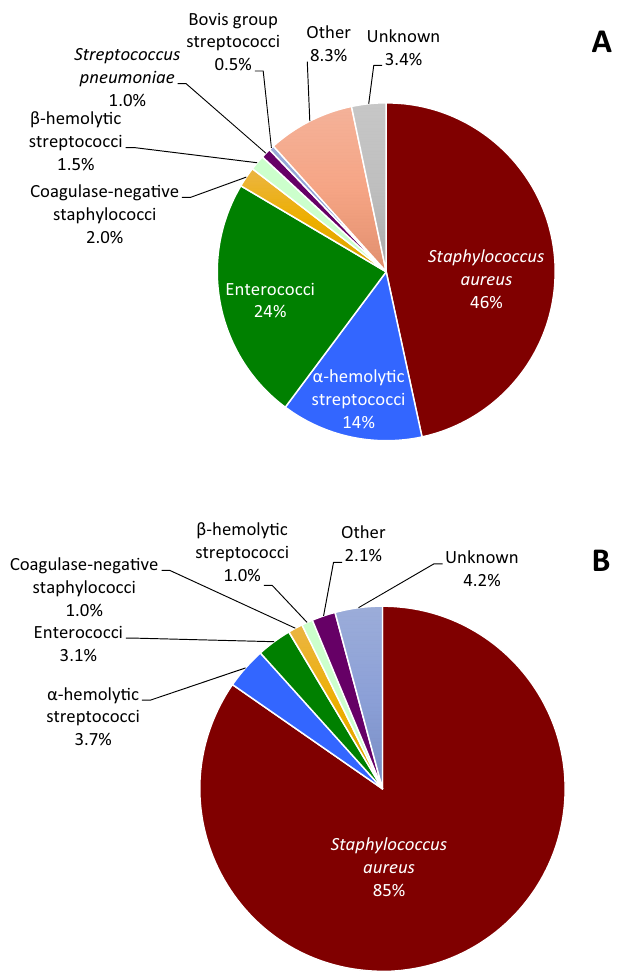
Figure 2. Microbiology: left-sided IDU-IE (A) ; right-sided IDU-IE (B) . HACEK, Haemophilus species, Aggregatibacter actinomycetemcomitans, Cardiobacterium hominis, Eikenella corrodens, Kingella kingae ; IDU, intravenous drug use; IE, infective